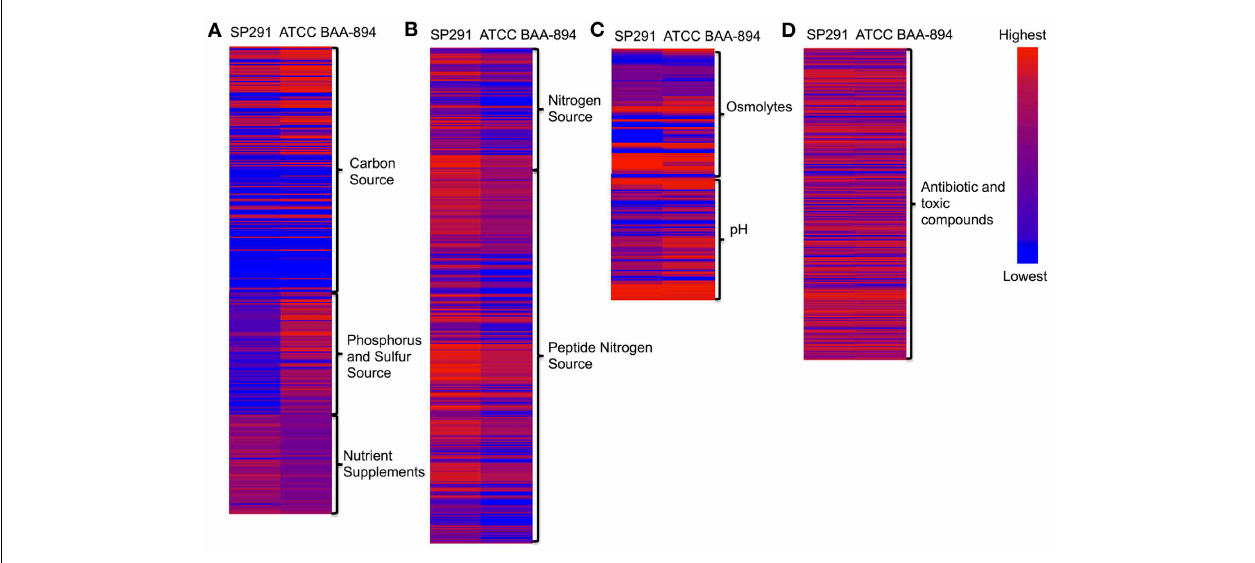
FIGURE 2 | (A–D) Heat map of phenotype microarray (PM). Left lane, C. sakazakii SP291; Right lane, C. sakazakii ATCC